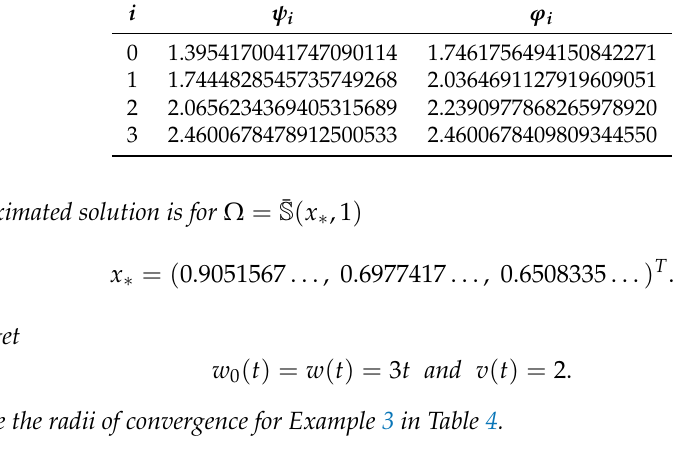
Table 4. Radii for Example